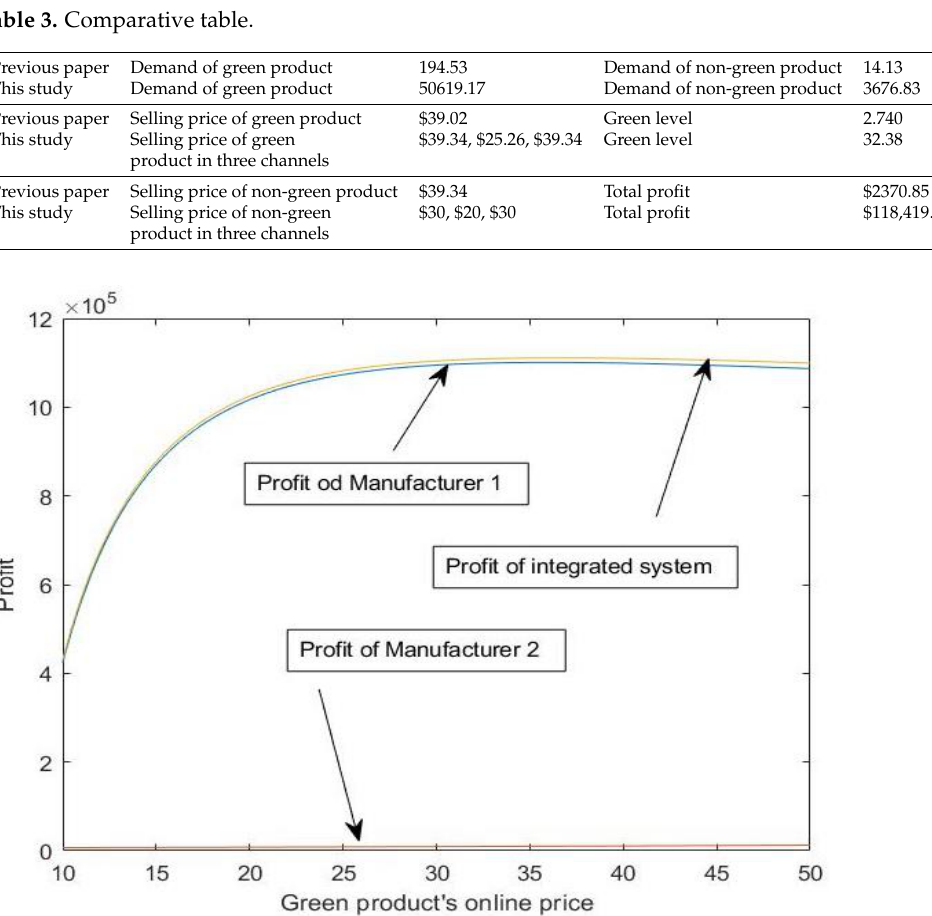
Figure 7. Graphical representation of changes of M1, M2, and integrated system’s profit versus GQ.